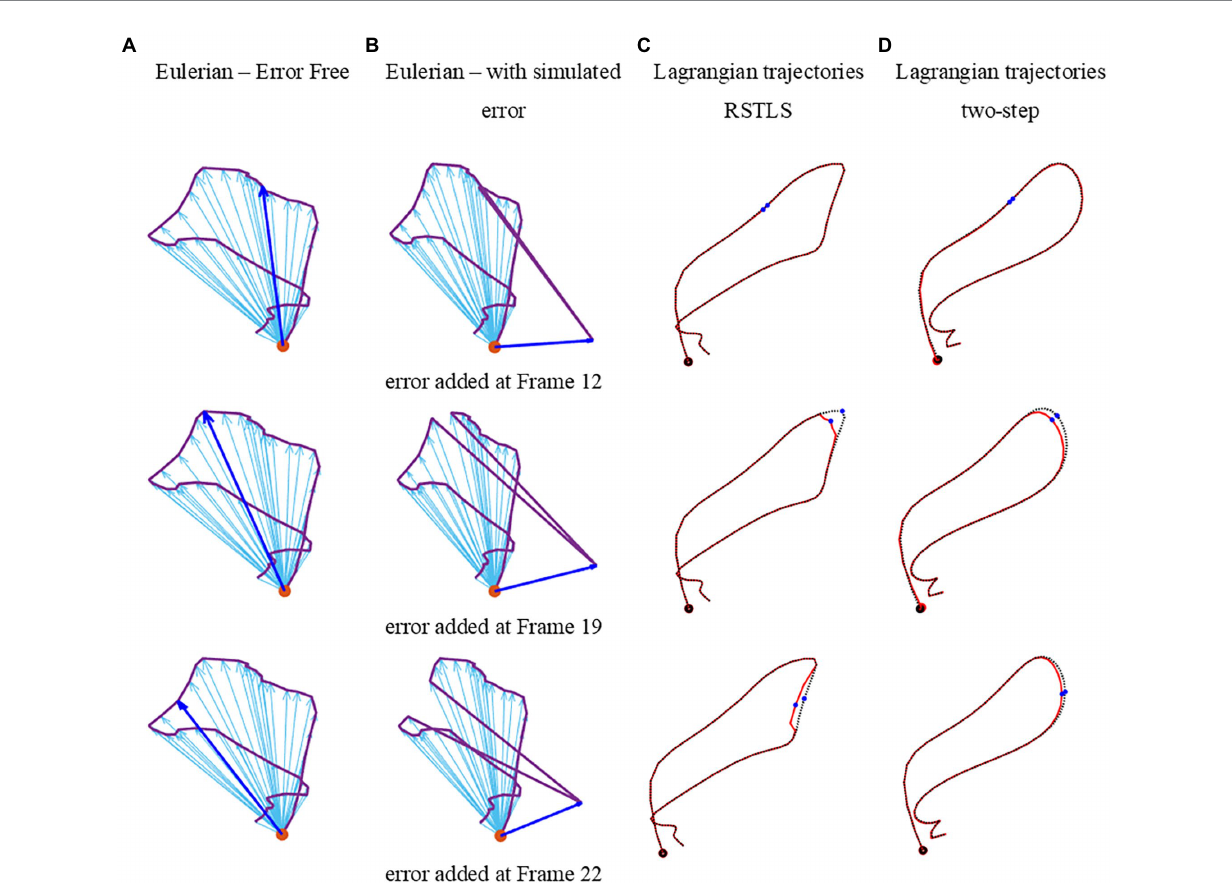
FIGURE 6 Examples of errors added to measured Eulerian displacements and their effects on computed Lagrangian displacements. (A) depicts the uncorrupted Eulerian displacements derived from DENSE unwrapped phase data from one pixel at all time points. The dark blue arrow corresponds to the Eulerian displacement of the time frame selected for adding a simulated measurement error. The new corrupted Eulerian displacements with simulated measurement errors are shown in (D) , where the error displacement vector (blue vector) is perpendicular to the original vector. Panel (C) shows the computed Lagrangian trajectories using the RSTLS method without and with the simulated error (the dotted black line shows the uncorrupted Lagrangian trajectory and the solid red line shows the corrupted Lagrangian trajectory). The blue dots in the Lagrangian trajectories show the time points where the simulated error was inserted. Panel (D) is the same as (C) , except it was generated using the two-step method instead of the RSLTS method for computing the Lagrangian